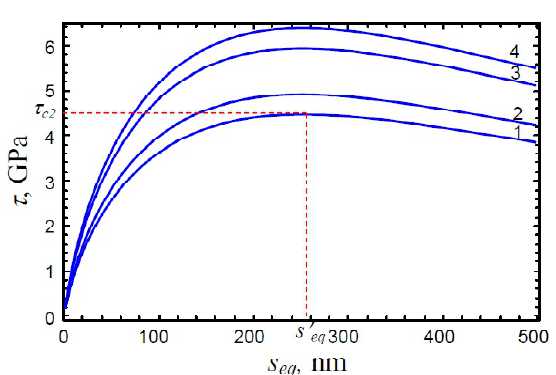
Fig. 3. Dependences of the external shear stress  on the equilibrium migration length s of GB migration accompanied by twin boundary migration (curves 1 and 3) and GB migration in ab- sence of nanotwins (curves 2 and 4), at various val- ues of misorientation parameter W = 30 ° (curves 1 and 2 ) and 40 ° (3 and 4). Correspondence  and s is correct to the left of the point ( s ’